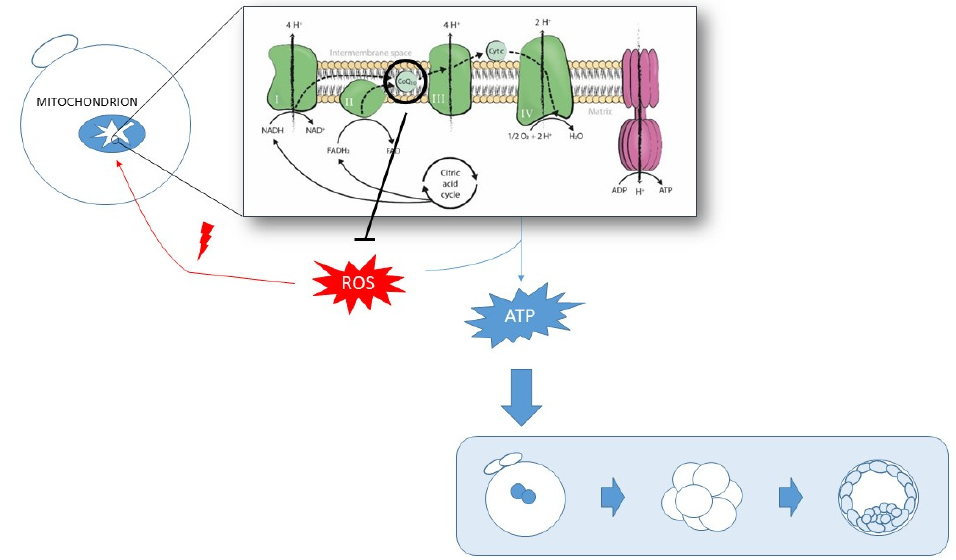
Figure 3. Schematic representation of the role of mitochondria and CoQ10 in acquiring optimal oocyte quality by means of ATP production and ROS counteraction.